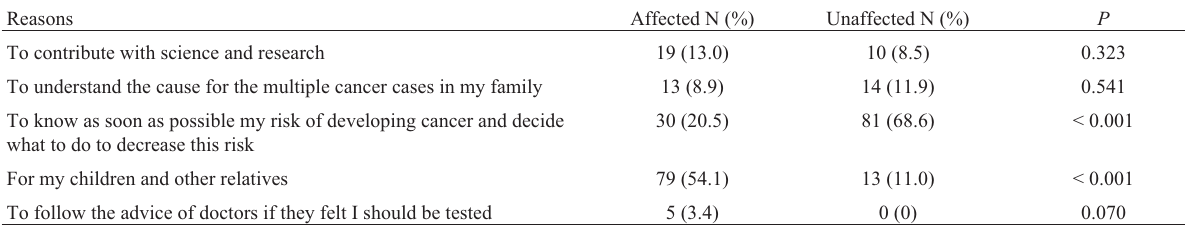
Table 2 - Reasons for undergoing genetic testing as reported by cancer-affected and unaffected